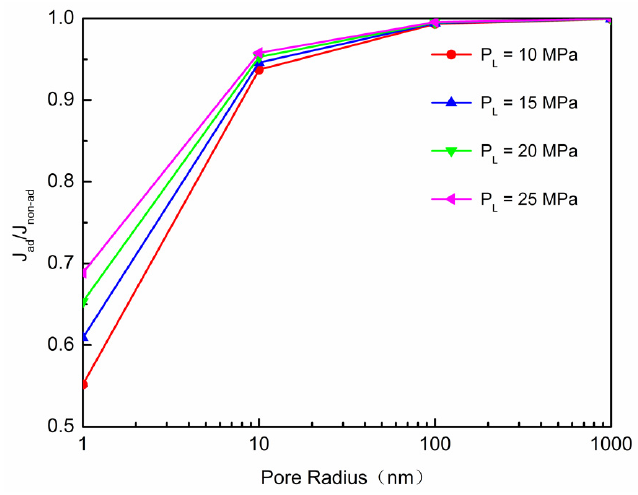
Figure 5. J ad / J non-ad ratio versus pore radius for various Langmuir pressures.